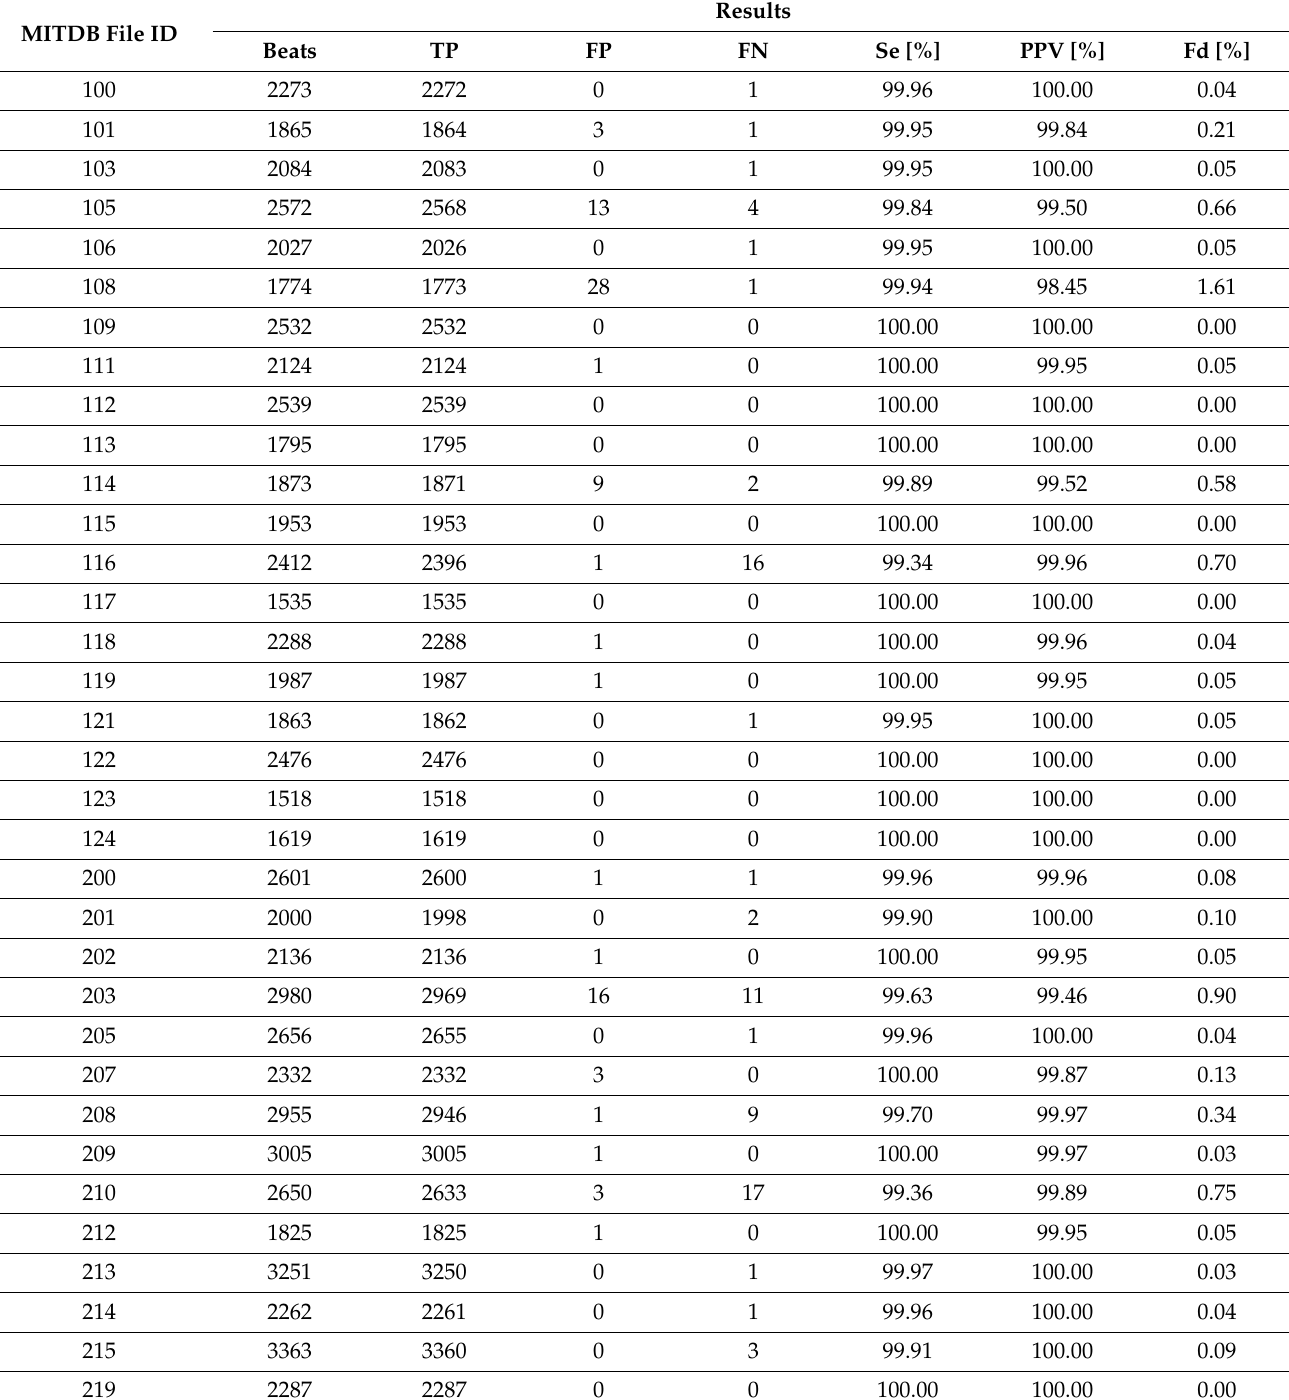
Table 2. Summary of performance ratios for individual nECG MITDB